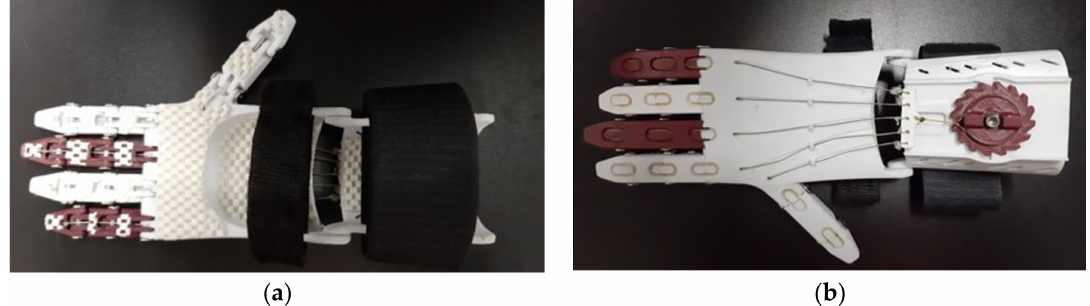
Figure 19. Built-in device model: ( a ) view palmar region of device, ( b ) top view of